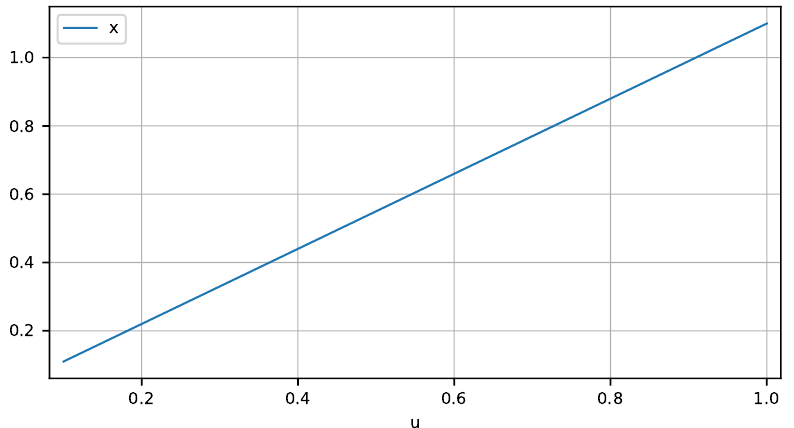
Figure 7. Steady-state simulations of model firstOrder with u = 0.1:0.1:1.0 and k =